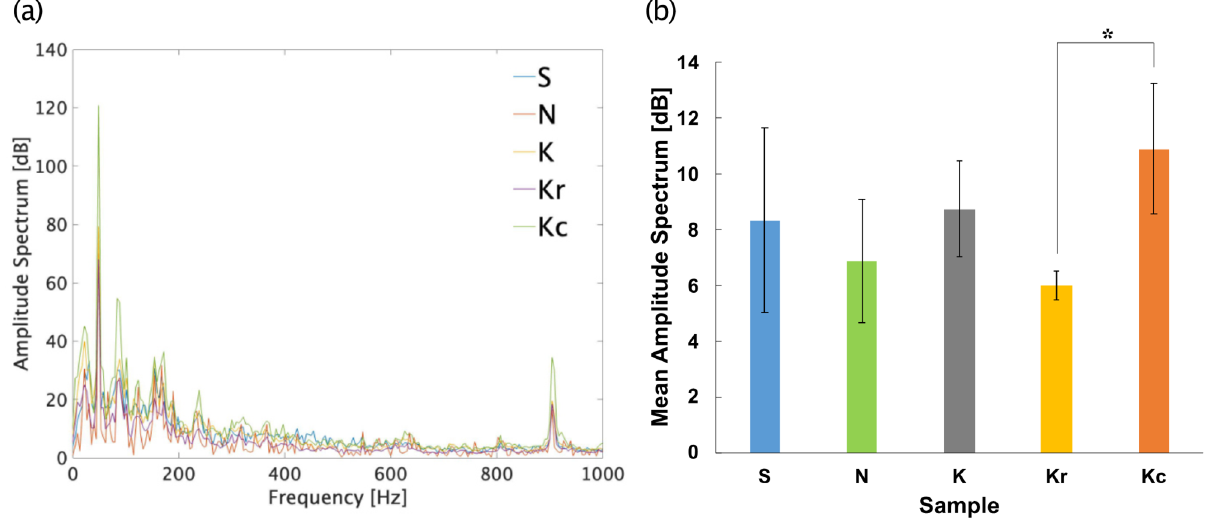
Figure 10. Results of the sound recording session in Experiment 2. ( a ) Power spectrum of the mastication sounds. ( b ) Mean power spectrum in each trial for each sample. * p < 0.05. Samples S, K, and N are available commercially and produced by different manufactures. Sample Kr was a moisturized and re-dried version of K, and Kc was a crushed version of K.